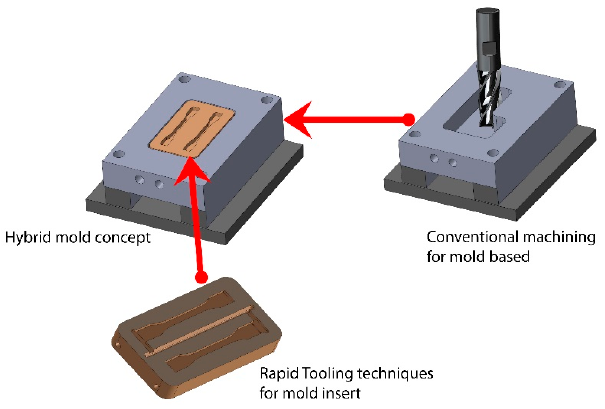
Figure 1. Concept of a hybrid mold.